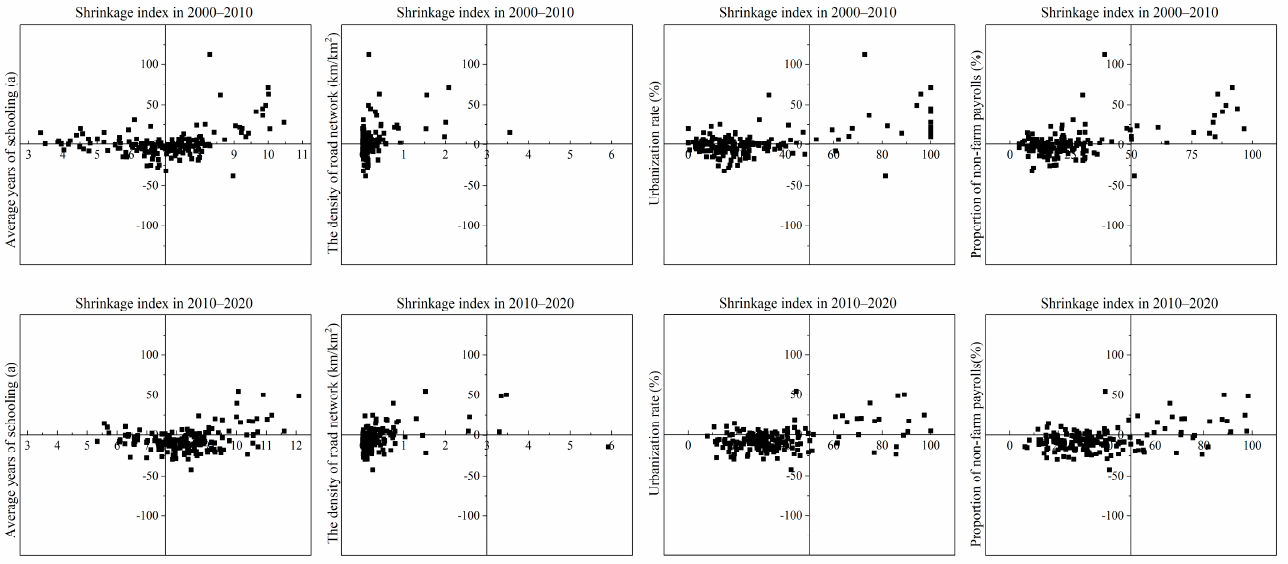
Figure 9. Scatter diagram of four human influencing factors in the North–South Transitional Zone of China.